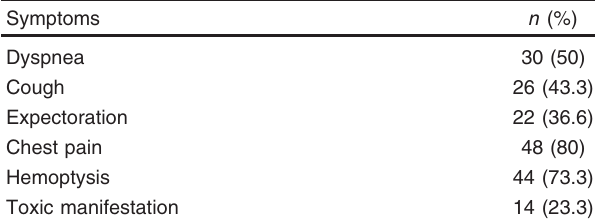
Table 2 Presenting symptoms of